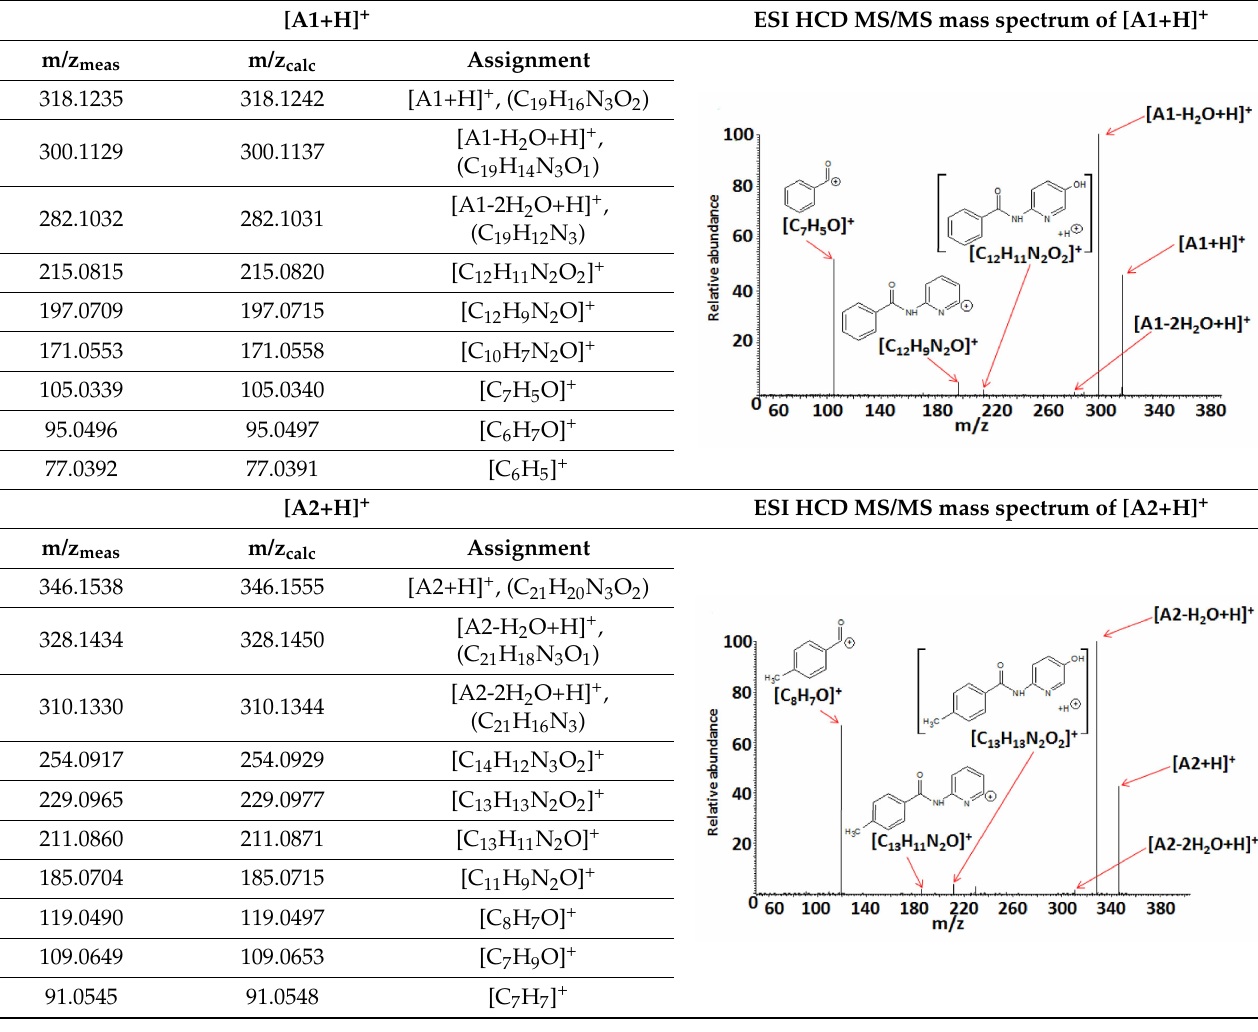
Table 5. Fragments observed following higher energy collisional dissociation (HCD MS/MS) of the following singly charged protonated ions: [A1+H] + , [A2+H] + , and [A3+H] + , respectively and the relevant ESI HCD MS/MS mass spectra [A1+H]